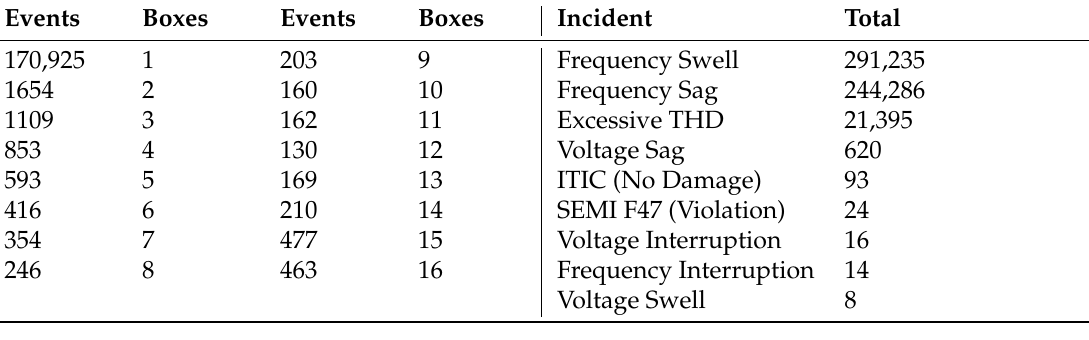
Figure 9. Summary statistics of ( a ) boxes involved in events and ( b ) incident type